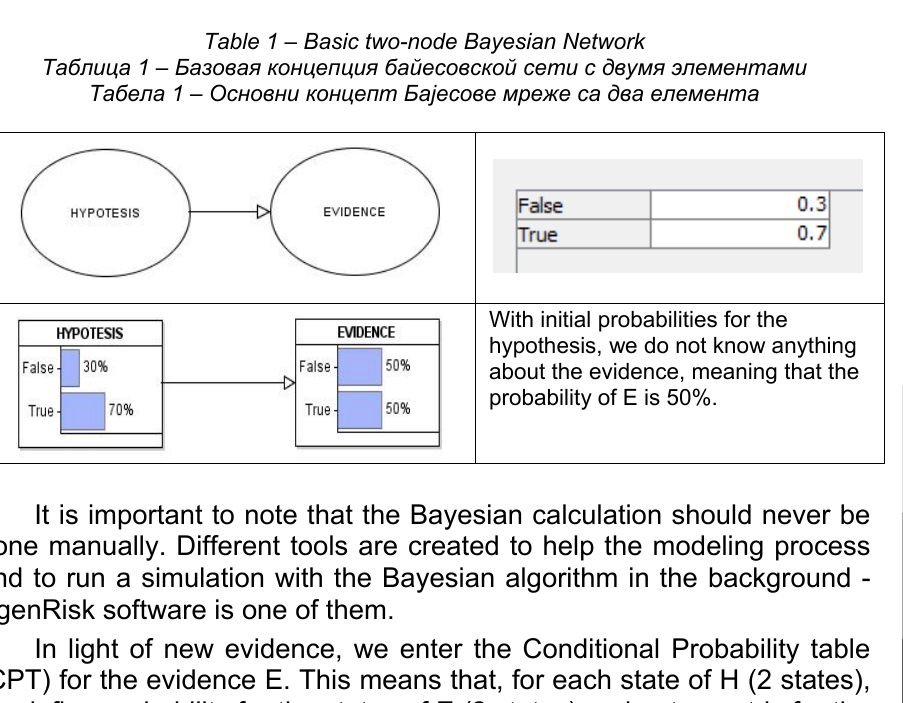
Table 1 – Basic two-node Bayesian